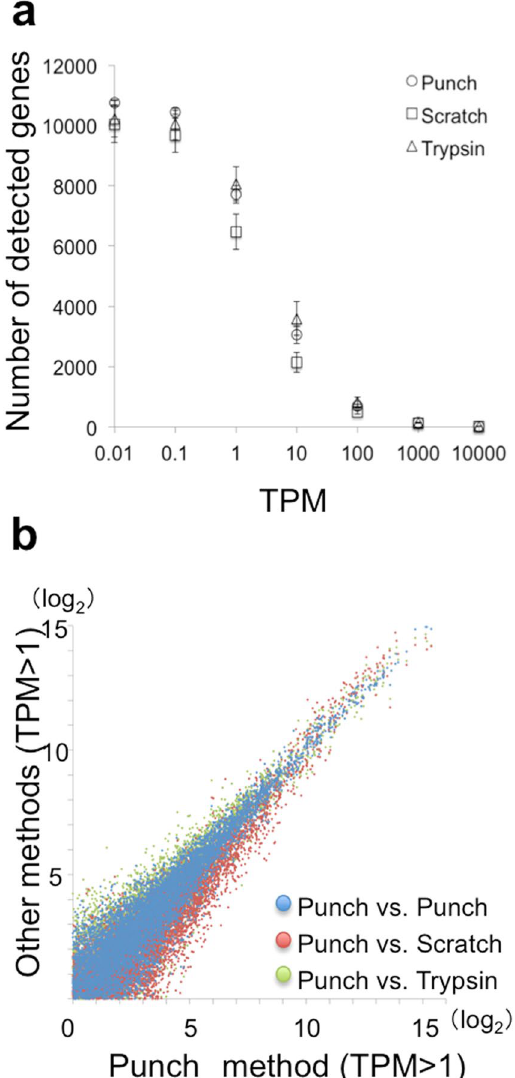
Figure 2. Number of genes identified and scatter plots for the three methods. ( a ) Numbers of observed gene species vs. minimum TPM. Error bars represent standard deviations. ( b ) Scatter plots of gene expression levels obtained with the punching method and the other methods (in Log2 TPM